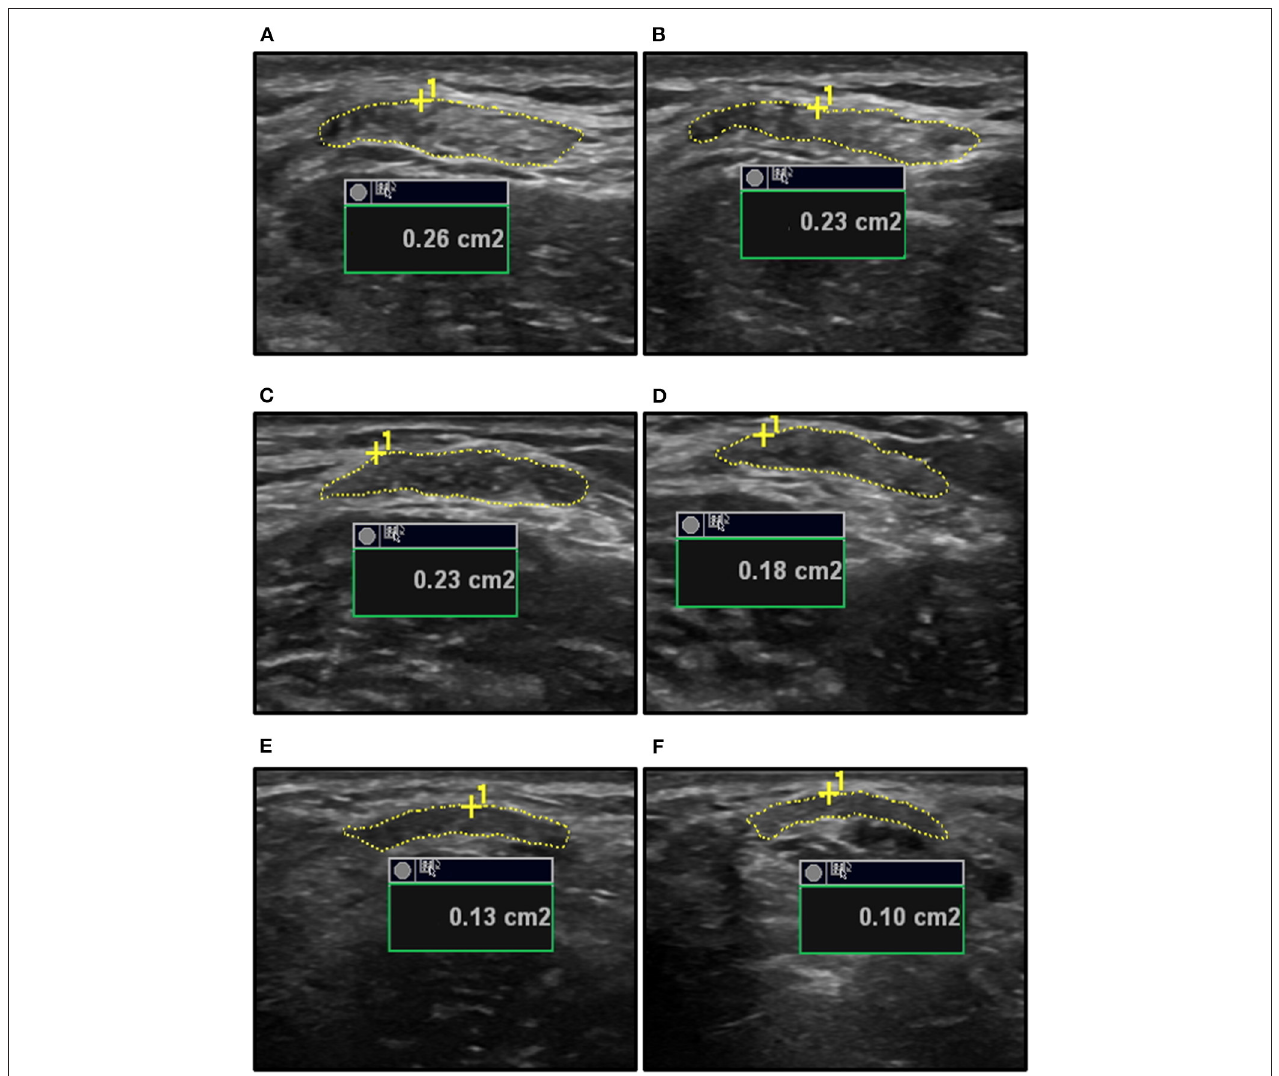
FIGURE 1 | The ultrasound measurements of biceps brachii (BB) tendon cross-sectional area (CSA) for a young male at rest (A) and during a 20% MVC contraction (B) , an old male at rest (C) and during a 20% MVC contraction (D) , and a young female at rest (E) and during a 25% MVC contraction (F) . The inherent measurement platform of the ultrasound provides the area in square centimeters (cm 2 ) and this was converted to square millimeter (mm 2 ) prior to the calculations of tendon stress using the resting and the instantaneous tendon CSA measures. MVC, maximal voluntary contraction.